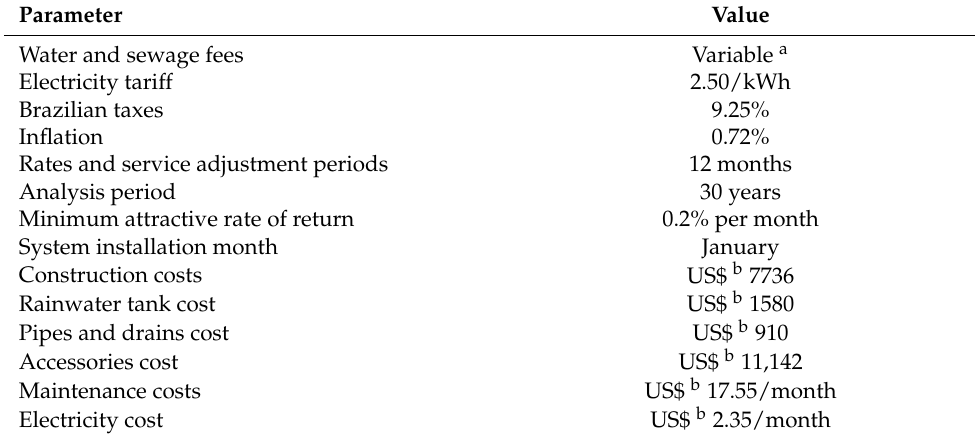
Table 3. Input data for the financial analysis.